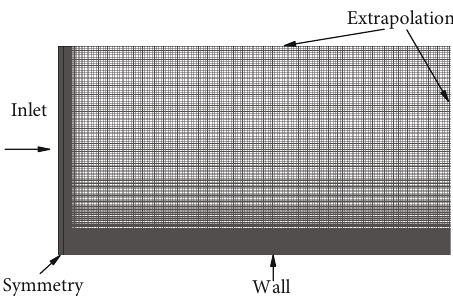
Figure 2: CFD mesh and boundary